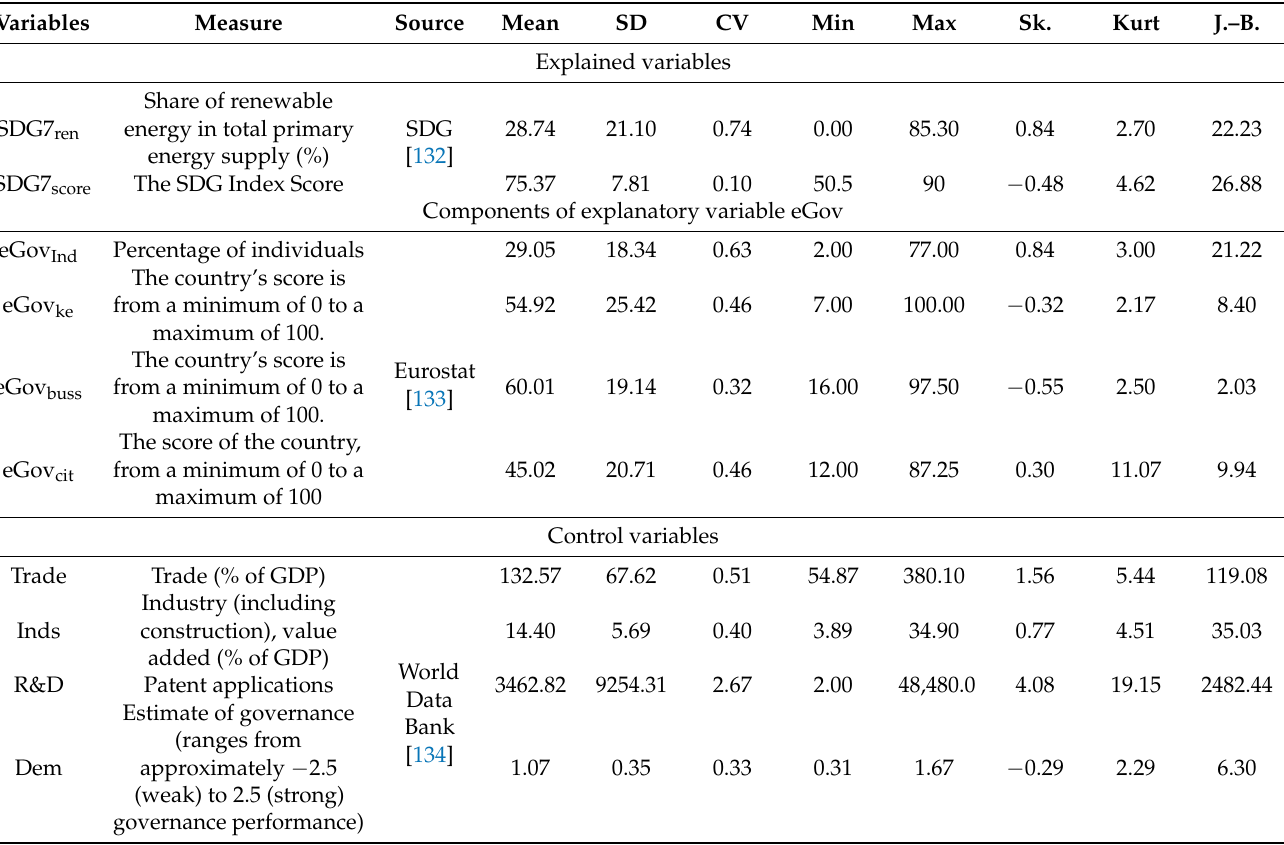
Table 1. The descriptive statistics of the selected